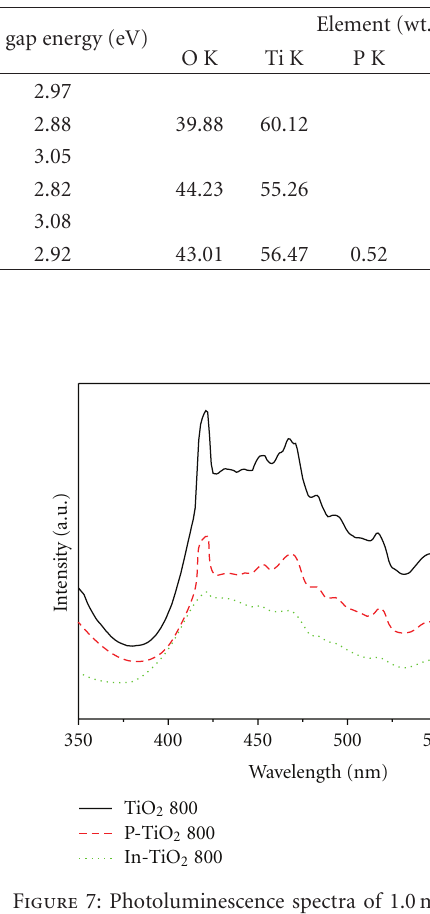
Figure 6: UV-Visible spectroscopy of 1.0mol% In, P incorporated TiO 2 photocatalysts.